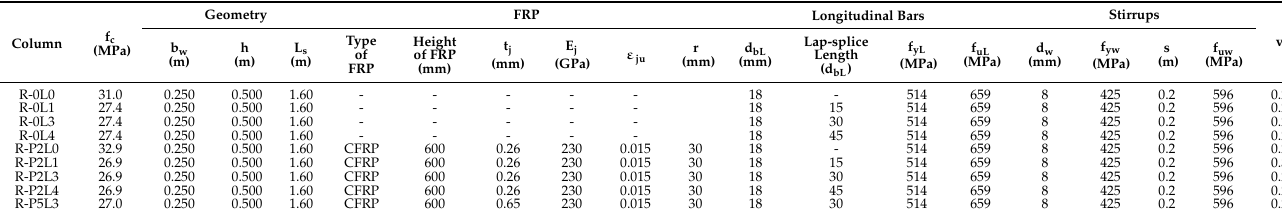
Table 1. Features of selected columns for pseudo-dynamic 3D FE